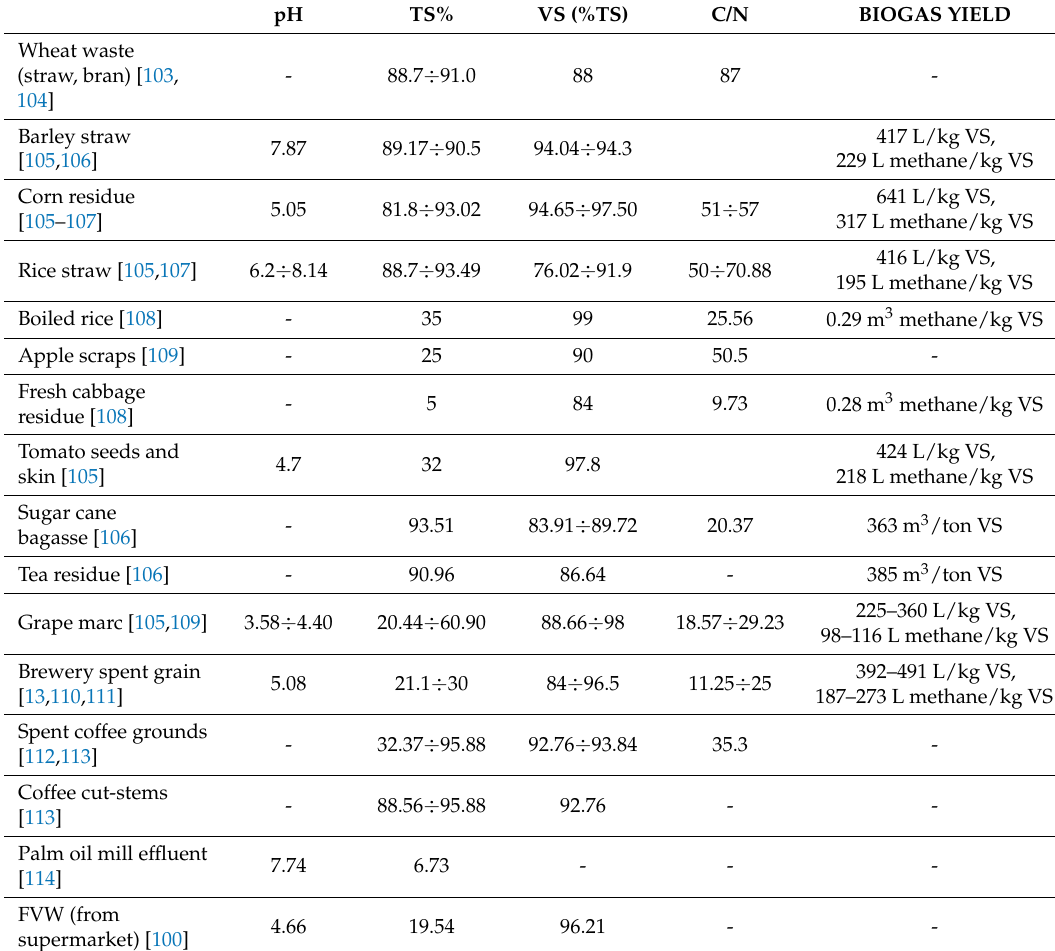
Table 5. Characteristics of some fruit and vegetable waste